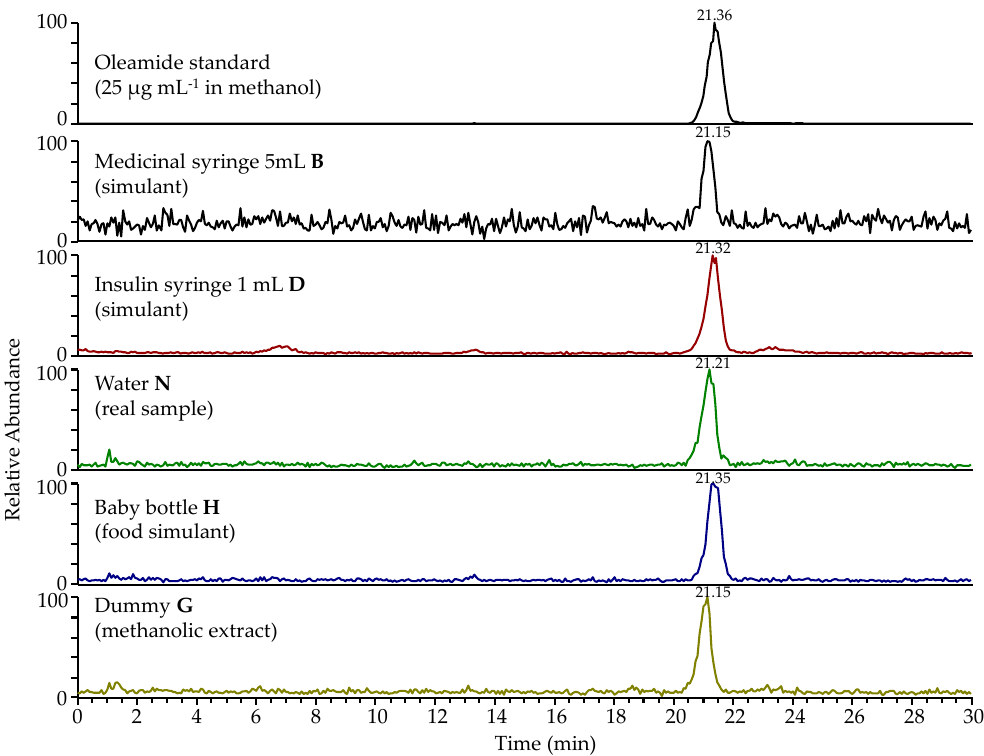
Figure 1. Selected ion monitoring (SIM) chromatograms of oleamide standard and some of the tested extracts, as shown in Table 1.